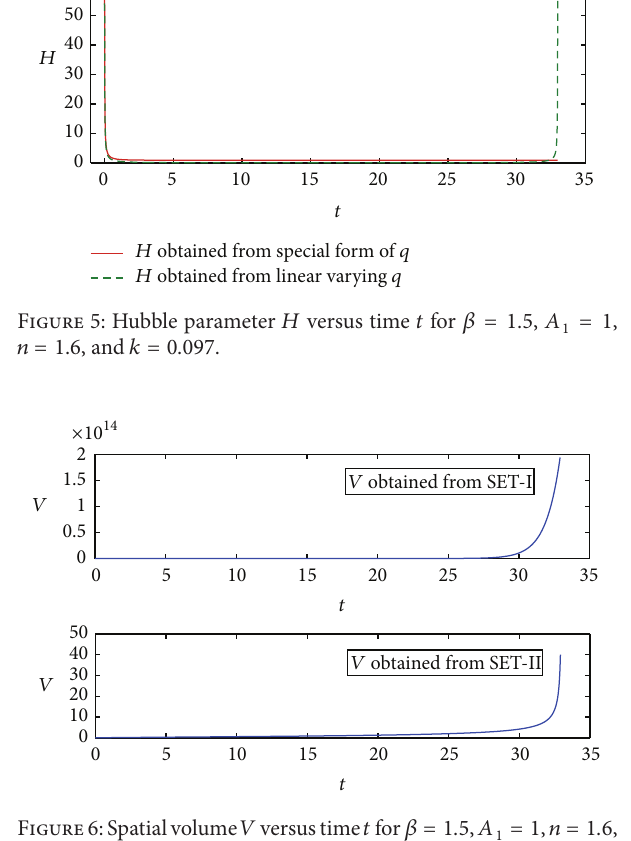
Figure6:Spatialvolume 𝑉 versustime 𝑡 for 𝛽 = 1 . 5, 𝐴 1 = 1, 𝑛 = 1 . 6, = 𝑘 = 0 . 097, and 𝑅 1